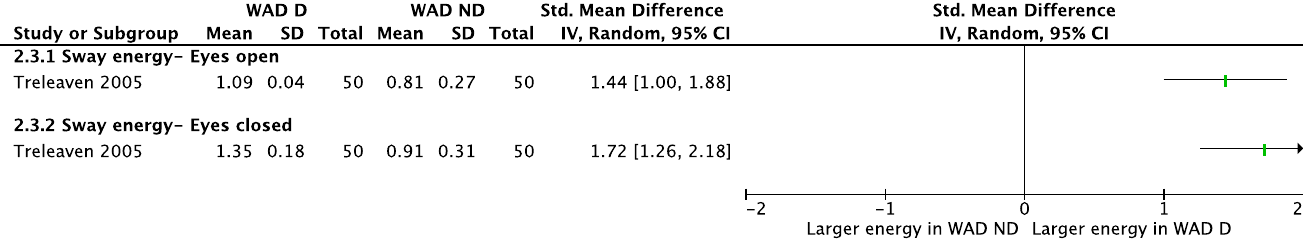
PLOS ONE | https://doi.org/10.1371/journal.pone.0249659 April 8,